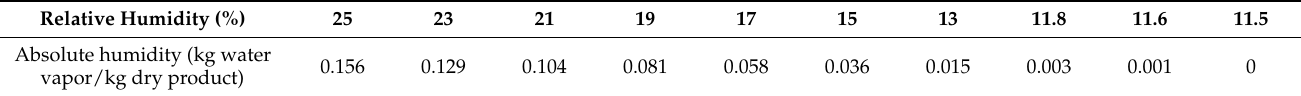
Table 4. Relative and absolute humidity of corn seeds.